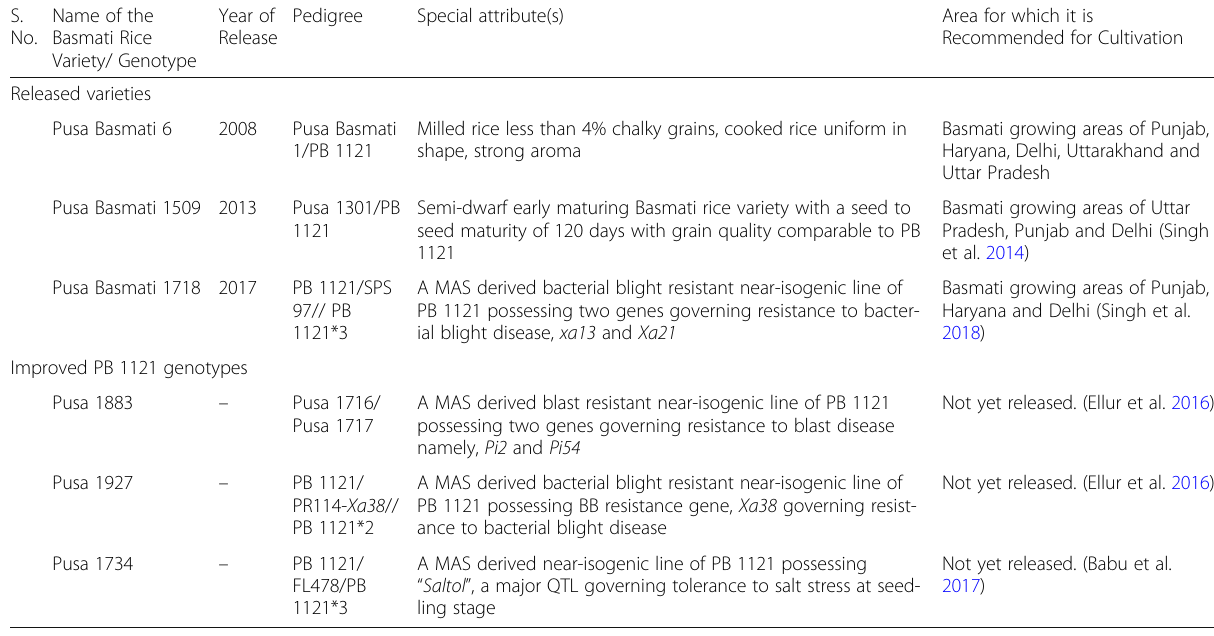
Table 3 Basmati rice varieties developed using PB 1121, along with characteristic features of the trait (genes incorporated) that has been